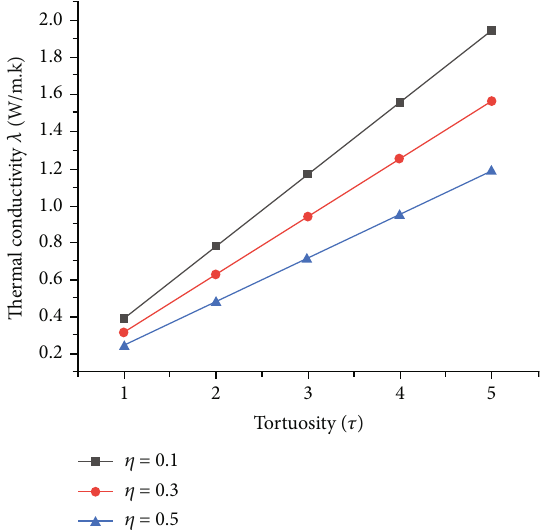
Figure 14: Relationship between thermal conductivity λ and tortuosity τ of the detailed volume-weighted average REV model with di ff erent pore channel distribution coe ffi cient η .